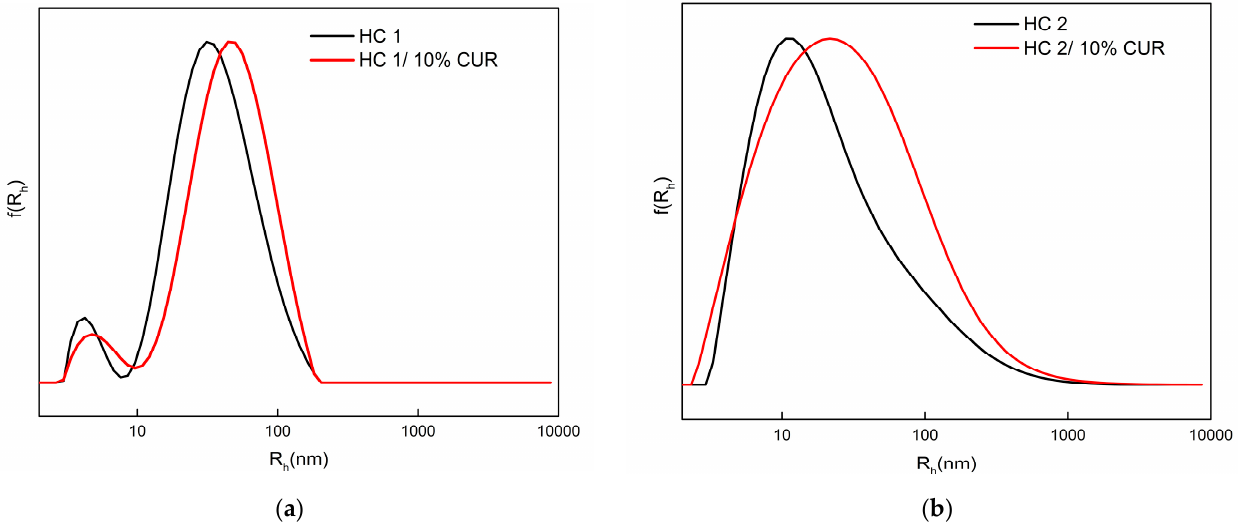
Figure 8. Size distributions from DLS analysis for the neat and CUR-loaded NPs of HC 1 ( a ) and HC 2 ( b ). HC 2 ( b ). Table 4. DLS and ELS results for the neat and CUR-loaded Table 4. DLS and ELS results for the neat and CUR-loaded PNPs.